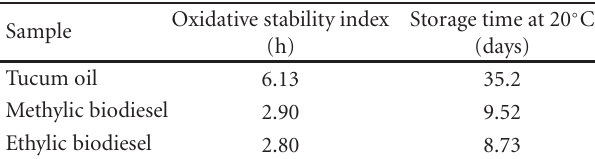
Table 1: Oxidative stability index and storage time studies obtained for the tucum oil and the methylic and ethylic